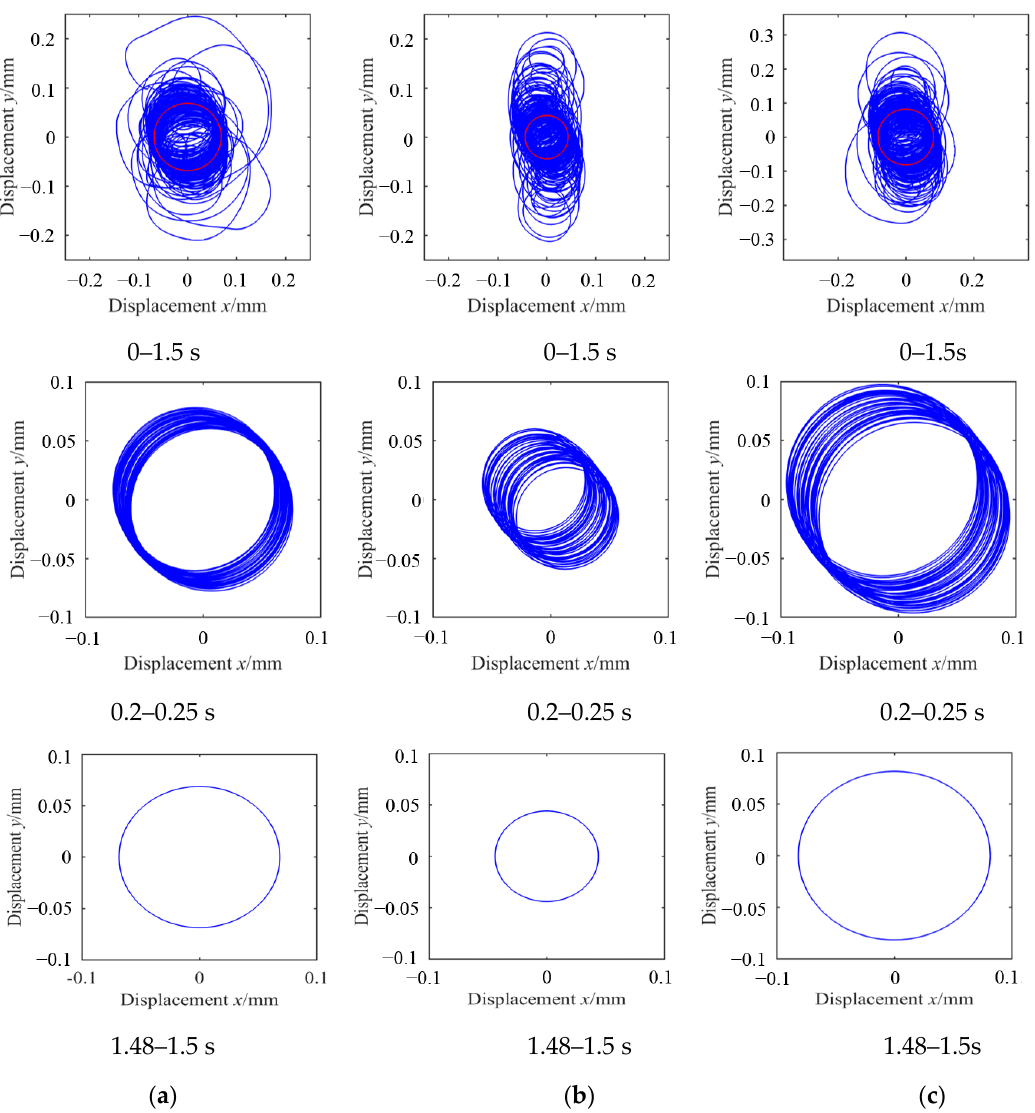
Figure 13. The motion orbits at different positions over time: ( a ) 1# bearing; ( b ) node 11 (C.G. position); ( c ) 2# bearing.